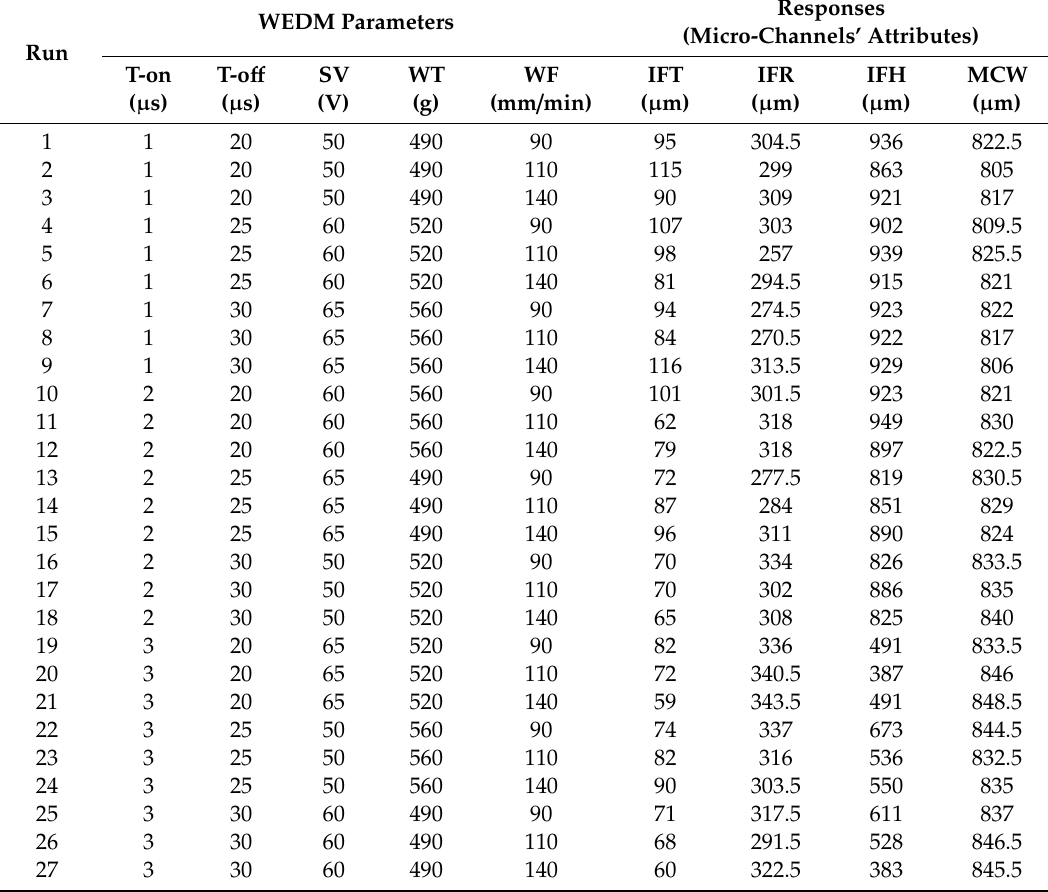
Table 4. Experimental results in terms of micro-channels attributes under Taguchi L27.